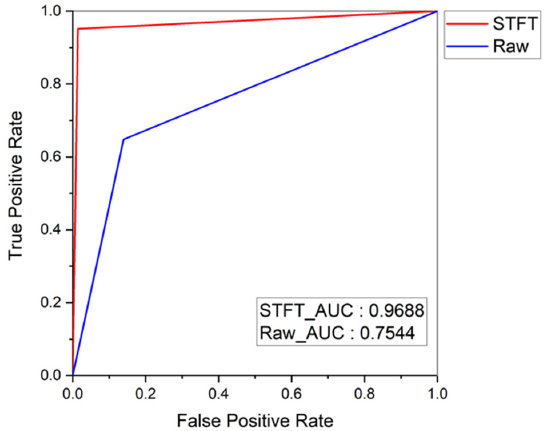
Figure 29. Comparison of AUC value of STFT and raw data (Time-domain).